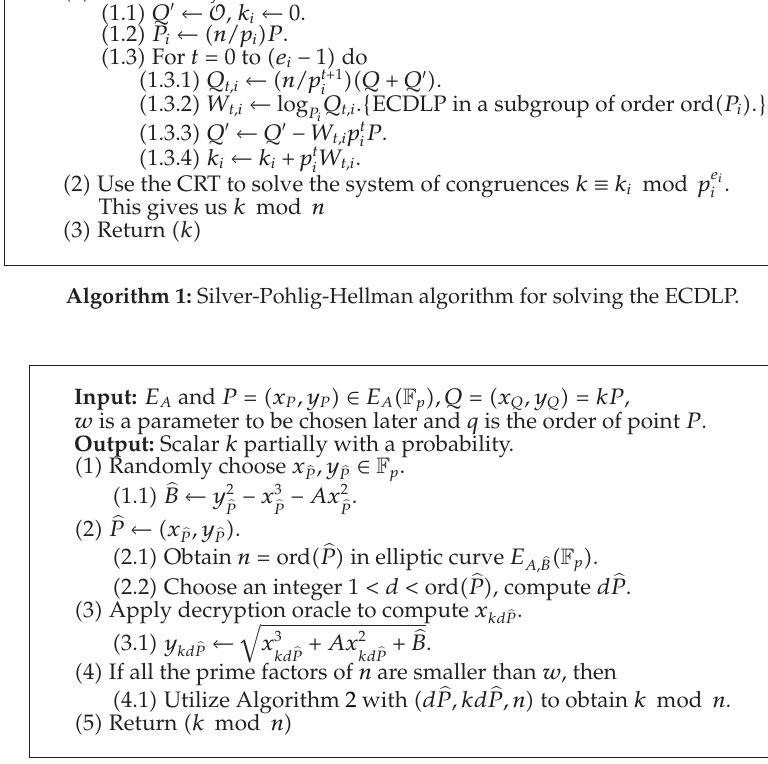
Algorithm 2: Basic fault attack on ECSM